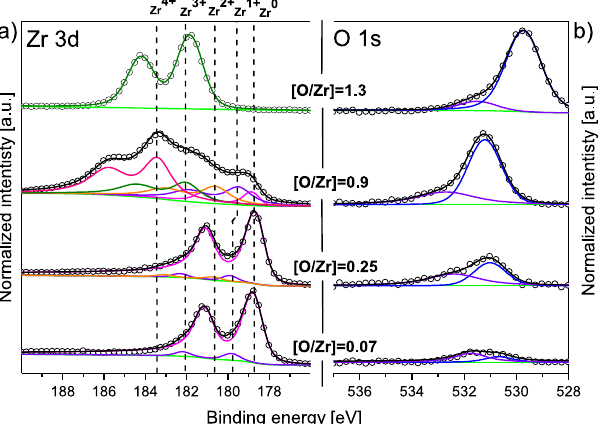
Figure 1. ( a ) Core level Zr3d spectra (XPS) for bulky ( ≥ 40 nm) metallic     = . ( ) 0 07 O and partially oxidized Zr O as well as for thin oxide films     = . ( ) 5mn, 1 3 O with different oxidation films     = .     = . ( ) 0 25 and 0 9 O Zr Zr Zr states: Zr 0 for metallic, Zr 1 + , Zr 2 + , Zr 3 + for sub-oxides and Zr 4 + for stoichiometric oxide. ( b ) Core level O1s spectra (XPS) for the corresponding Zr3d spectra. The open circles stand for the measured spectrum and the black lines correspond to the sum curve of all components represented in the coloured lines. The vertical lines are given as a guide to the eye.